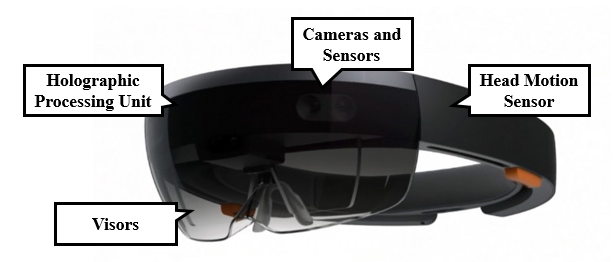
Figure 2. The mixed reality device HoloLens.